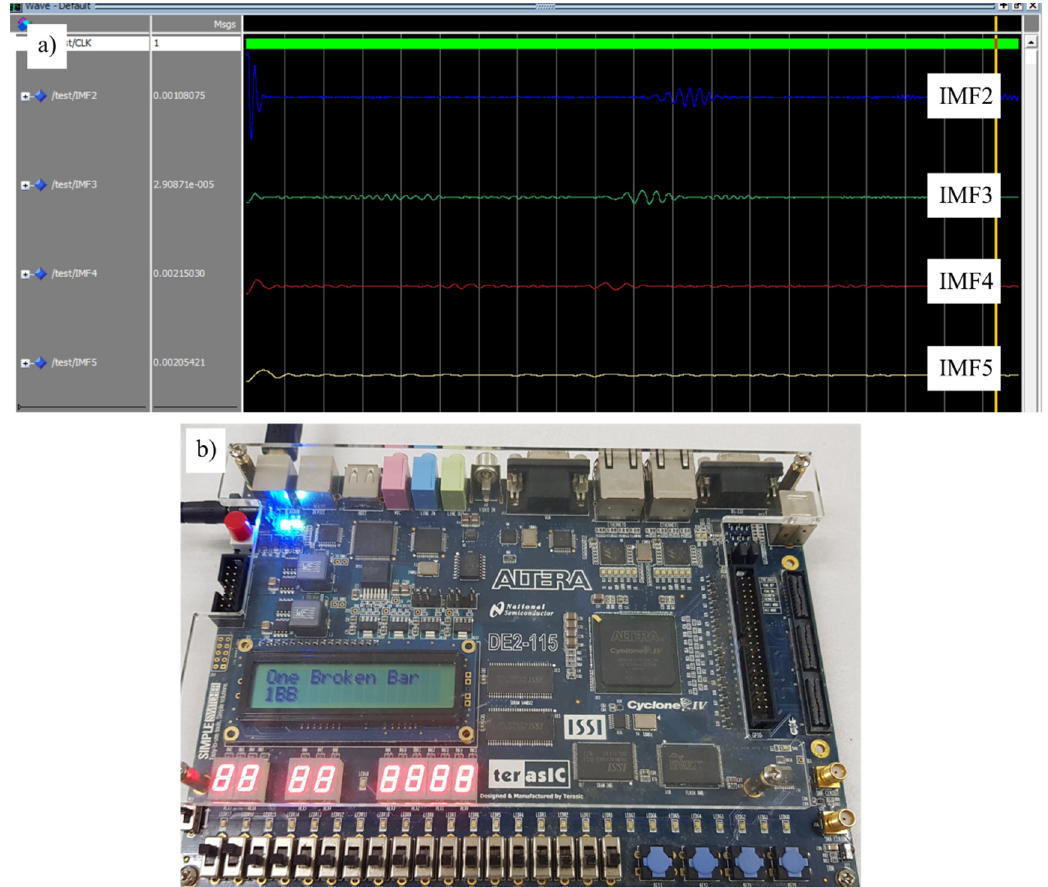
Figure 12. FPGA results: ( a ) IMFs extraction and ( b ) Diagnosis.